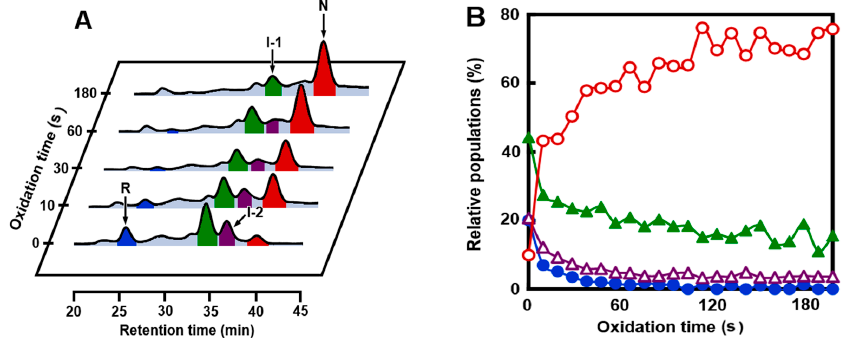
Figure 6. Oxidation pulse experiments. ( A ) RP-HPLC chromatograms obtained 0 to 180 s after addition of 1 eq DHS ox to the reaction mixture, which was obtained by the reaction of R and 1 eq DHS ox at pH 8.0 and 5 °C after 5 h. The oxidative folding conditions were the same as those of Figure 3B, but the reaction was quenched by AEMTS; ( B ) relative populations of R ( ● , blue), N ( ○ , red), I-1 ( ▲ , green), and I-2 ( △ , purple) as a function of the oxidation time.